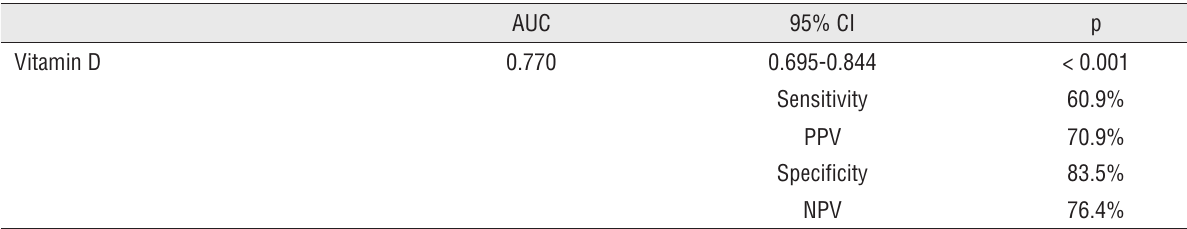
AUC =- area under curve; CI = confi dence interval; PPV = positive predictive value; NPV = negative predictive value.